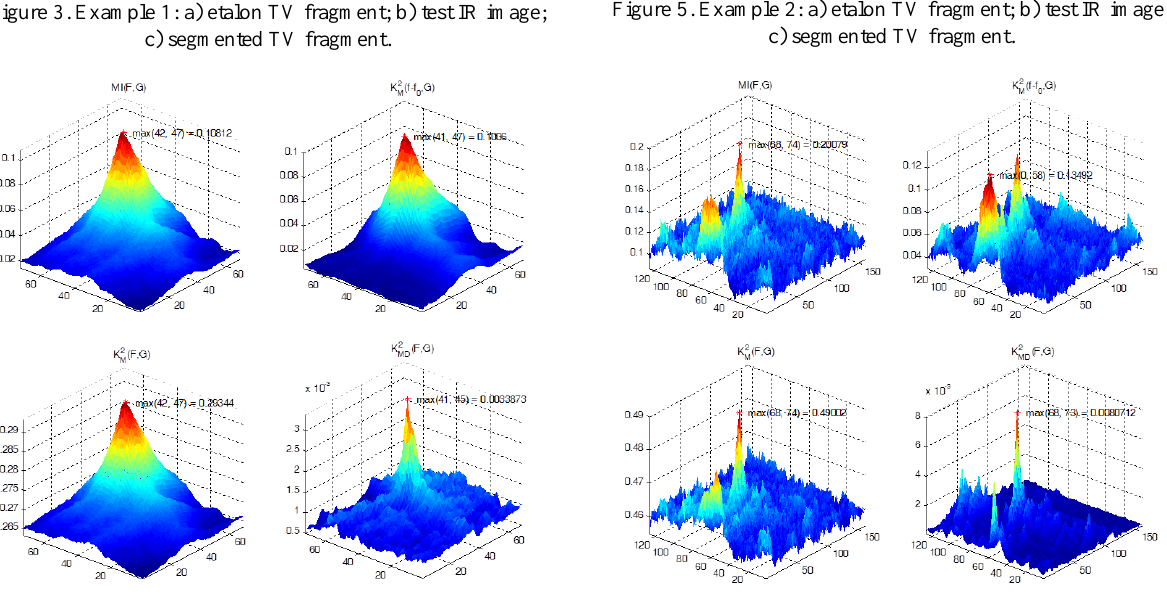
Figure 4. Correlation fields for TV-IR matching (Example 1).